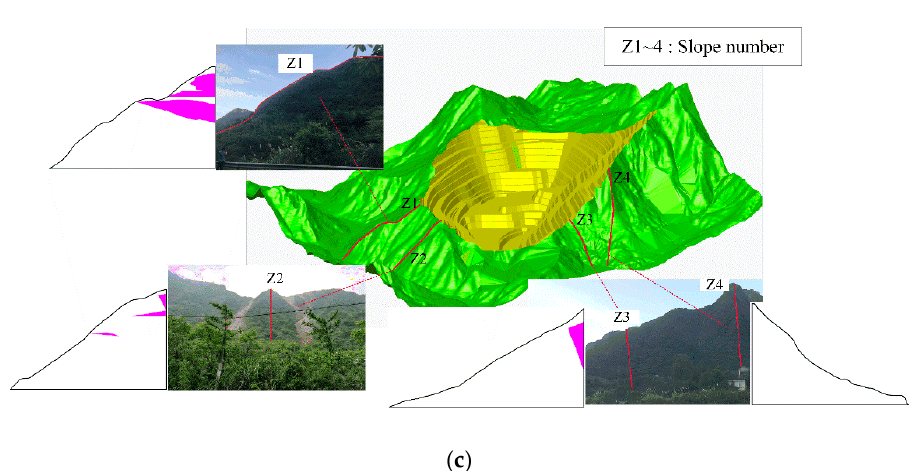
Figure 4. The slope section models: ( a ) diagram for the location of the selected slopes in the mining area; ( b ) artificial mining slopes; ( c ) natural slopes.